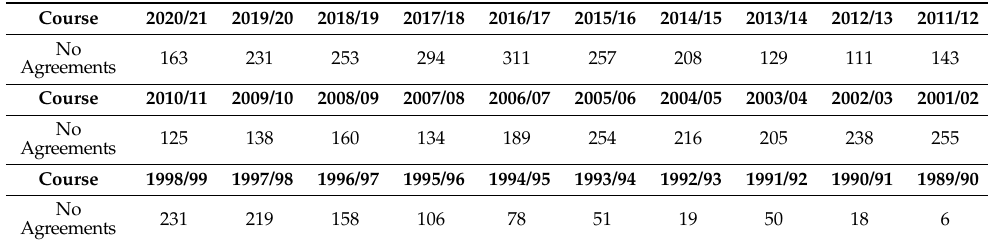
Table 2. Educational cooperation agreements for the years 1989/90 to